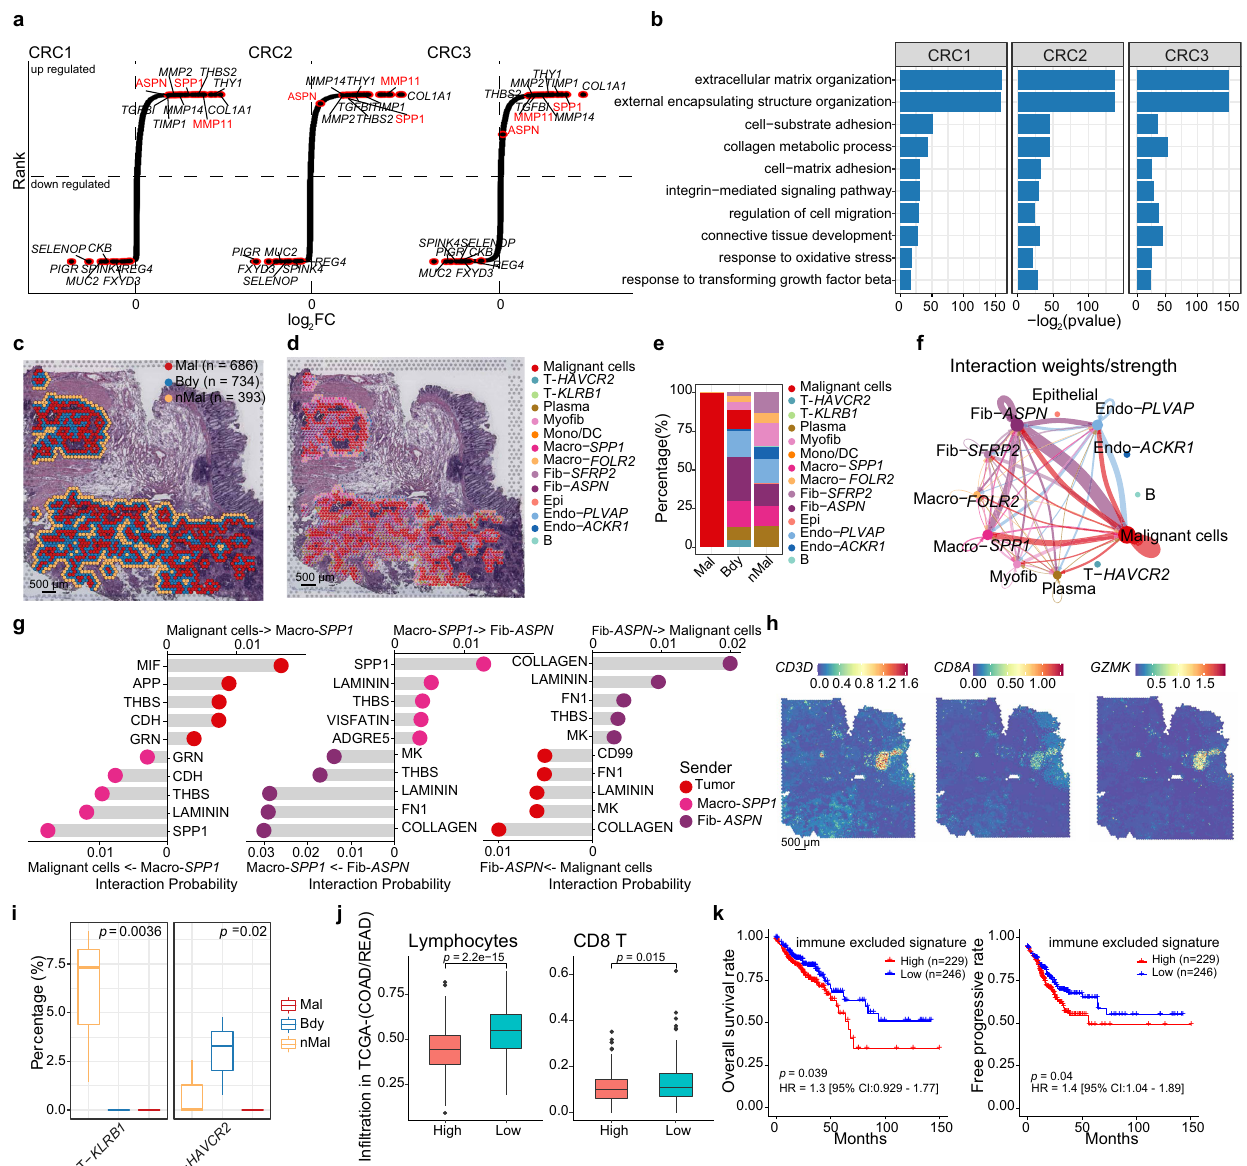
Fig. 5 | Characterization of microenvironment in tumor boundary. a Rank- ordered plot showing log2 fold change betweengene expressioninboundary spots and other spots in three CRC ST samples. b Gene ontology (GO) terms of genes signi fi cantly enriched in boundary spots of three CRC ST samples. The statistical analysis was performed by two-sided Fisher ’ s test. The location ( c ) and cellular composition in Pie plot ( d ) for boundary spots (blue), and its fi rst inner circle for malignant spots (red) and fi rst outer circle for non-malignant spots (orange). e Bar plots showing proportion of cell types in each region de fi ned in c . f Circle plot visualizing the cellular communication of cell types in three regions de fi ned in c . Circle sizes are proportional to the number of cells in each cell group and thickness ofthe fl owrepresentstheinteractionweight. g Lollipopplotshowingtheinteraction probability for signaling pathway between sender and receptor cell types. h Spatial